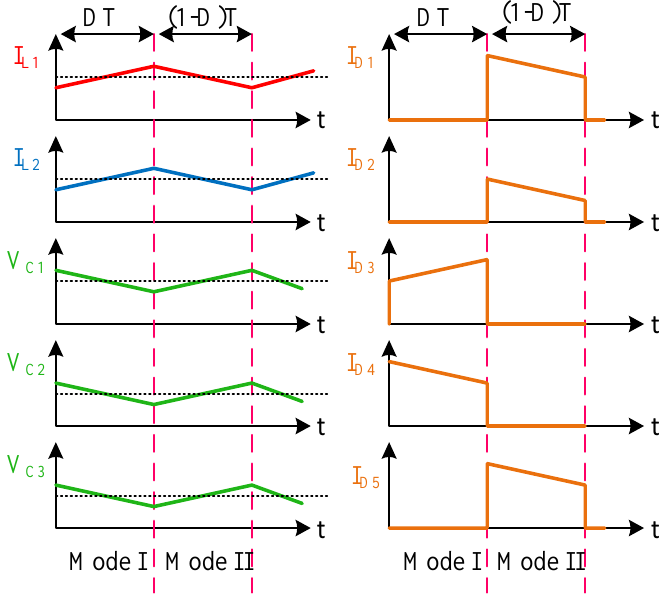
Figure 2. Typical waveforms of the proposed converter I in CCM. The voltage stress or blocking voltage of a power device is important for deciding the voltage rating of the switch. The voltage stress across the power switch (V S ) and diodes (D 1 , D 2 , D 3 , D 4 , and D 5 ) of the converter I can be derived